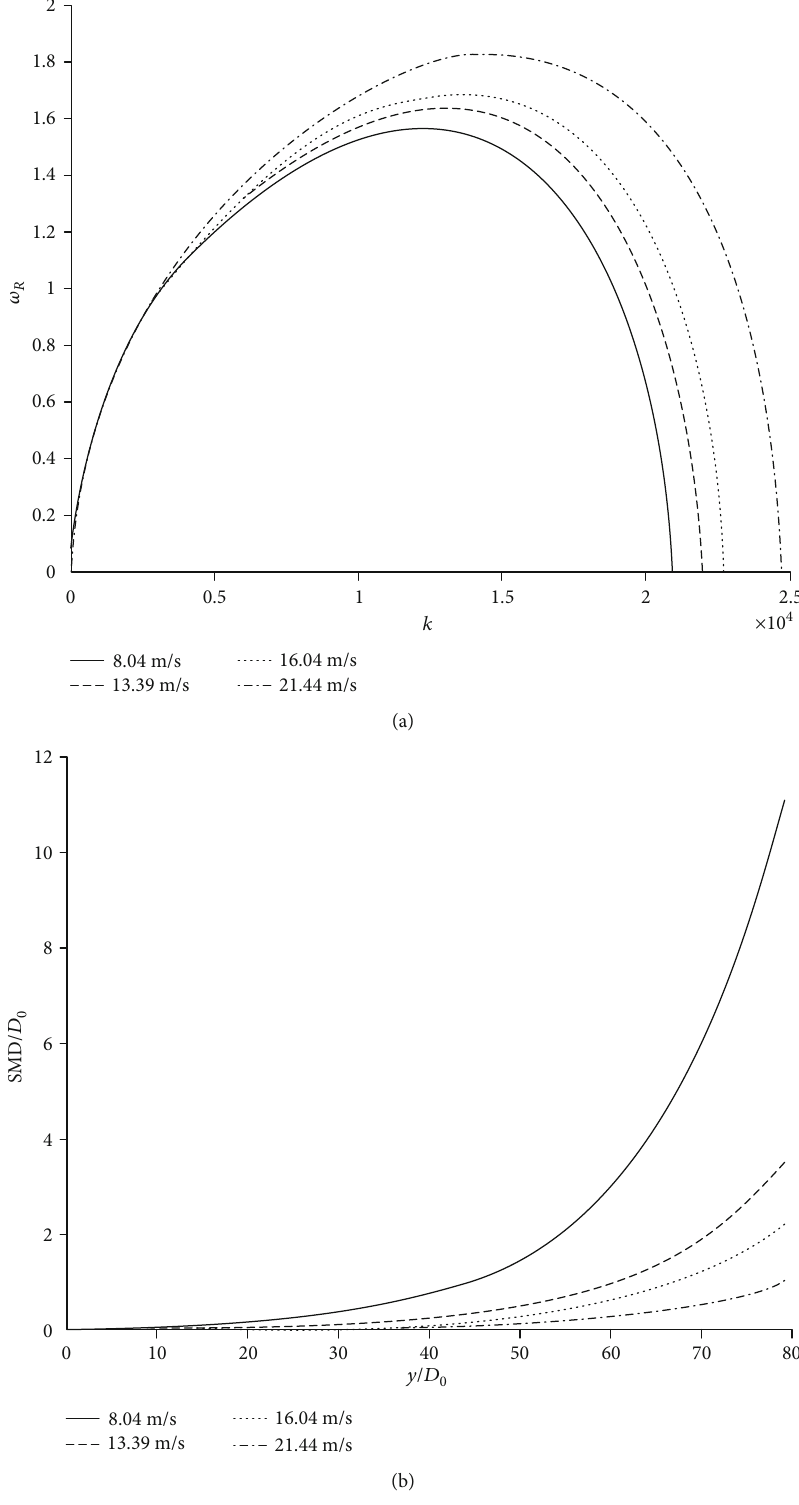
Figure 4: E ff ect of injection velocity to (a) surface wave growth rate and (b) droplet size distribution ( σ = 0 : 0728N/m 2 , ρ ρ = 1000kg/m 3 , and q = 96 : 35 L